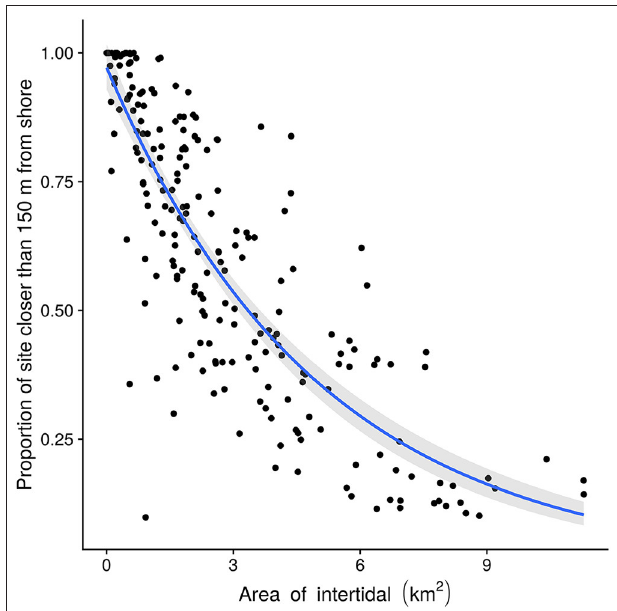
FIGURE 7 | Location danger as a function of size. The fitted line shows the log-linear trend of danger with intertidal area. Larger sites are generally less dangerous, but the danger index varies widely between sites of a given